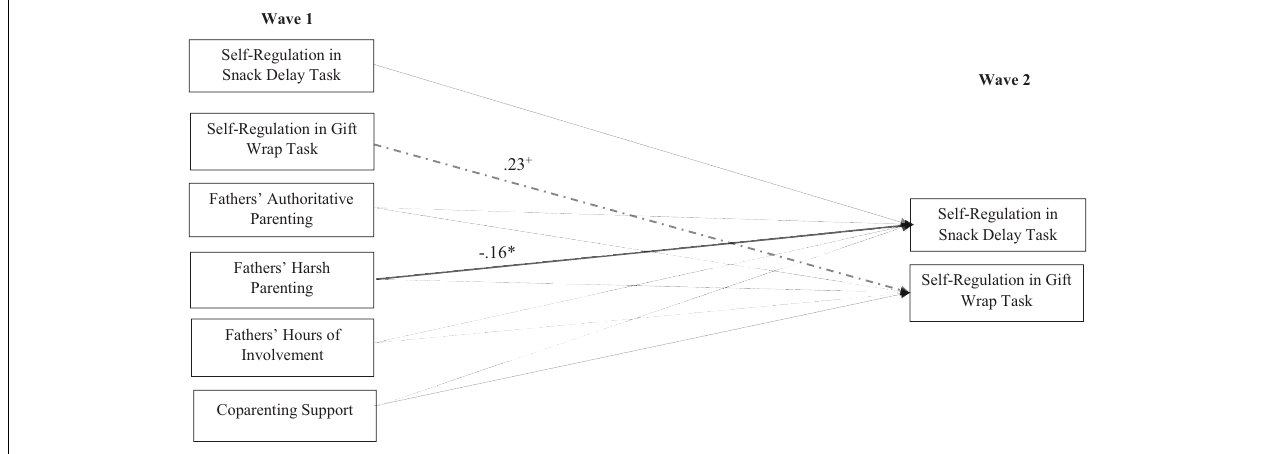
FIGURE 1 | Associations between resident fathers’ parenting, coparenting, and children’s self-regulation at Wave 1 and Wave 2. Child age, mothers’ parenting (i.e., authoritative and harsh), child gender, and father education level were included as control variables but (to more effectively show associations among paths of interest) were not included in the above figure. Statistically significant estimates are depicted in solid bold lines. Estimates that are statistically significant at trend-level are depicted in the dashed line. Dotted lines indicate estimates that were not statistically significant. χ 2 (29) = 34.15, p = 0.23; CFI = 0.950; RMSEA = 0.038; ∗ p < 0.05; + p <